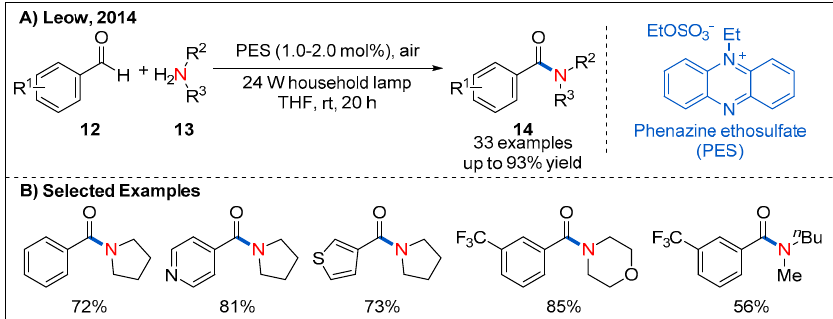
Figure 8. Selected organic photocatalysts for oxidative amidation of aldehydes. 2.5. From Acids Although the method of construction of amides through the condensation of carboxylic acids and amines under the condition of external activating reagents has been well estab- lished, stoichiometric coupling agents decrease the atom economy. Therefore, the develop- ment of efficient methods for catalytic activation of acids is urgently needed. In 2016, Tan, Qiu and Chen reported an elegant oxidative amidation of potassium thioacids 18 with amines 19 by photoredox catalysis, providing a green catalytic process for amide formation (Figure 9) [38]. As shown in Figure 9C, preliminary mechanistic studies revealed that diacyl disulfide 18-A derived from potassium thioacids under visible-light irradiation might be the key intermediate, and O 2 served as a green oxidant. This method has the characteristics of mild reaction conditions and good functional group compatibility. Primary, secondary aro- matic amines and even amino acids could participate in the reaction well, providing the final products in high yields (Figure 9B).